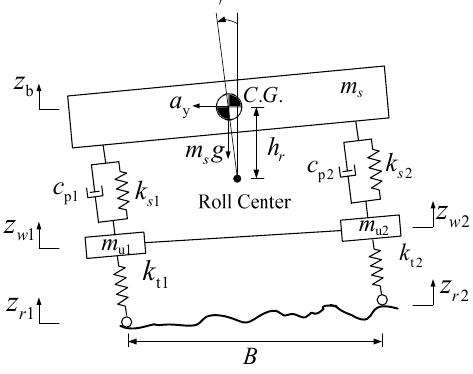
Figure 5. Half-car roll dynamics model. Table 2. Description of symbols for 6-DOF half-car dynamics model.